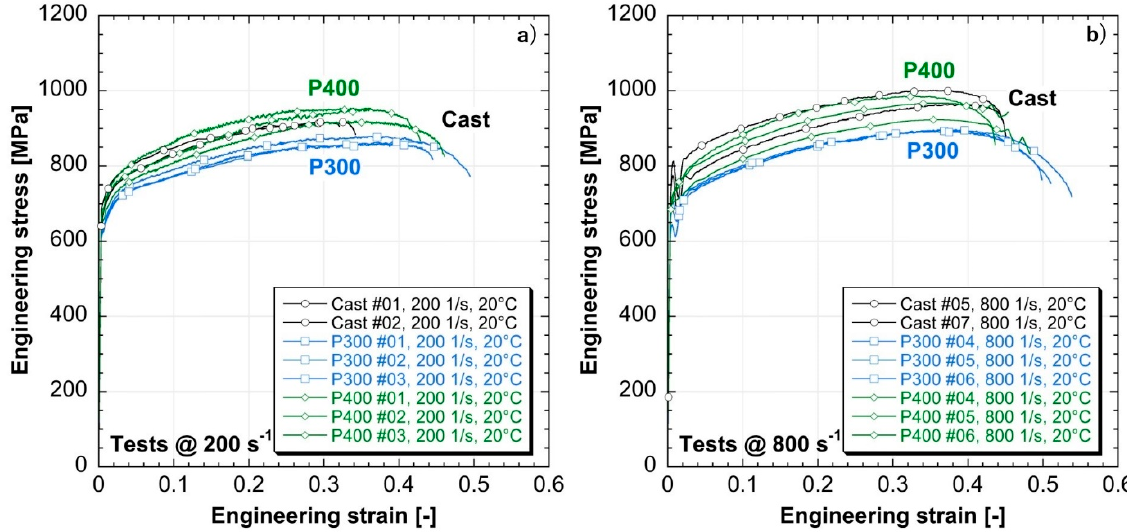
Figure 13. Mechanical tensile properties of the realized specimens: ( a ) at 200/s; ( b ) at